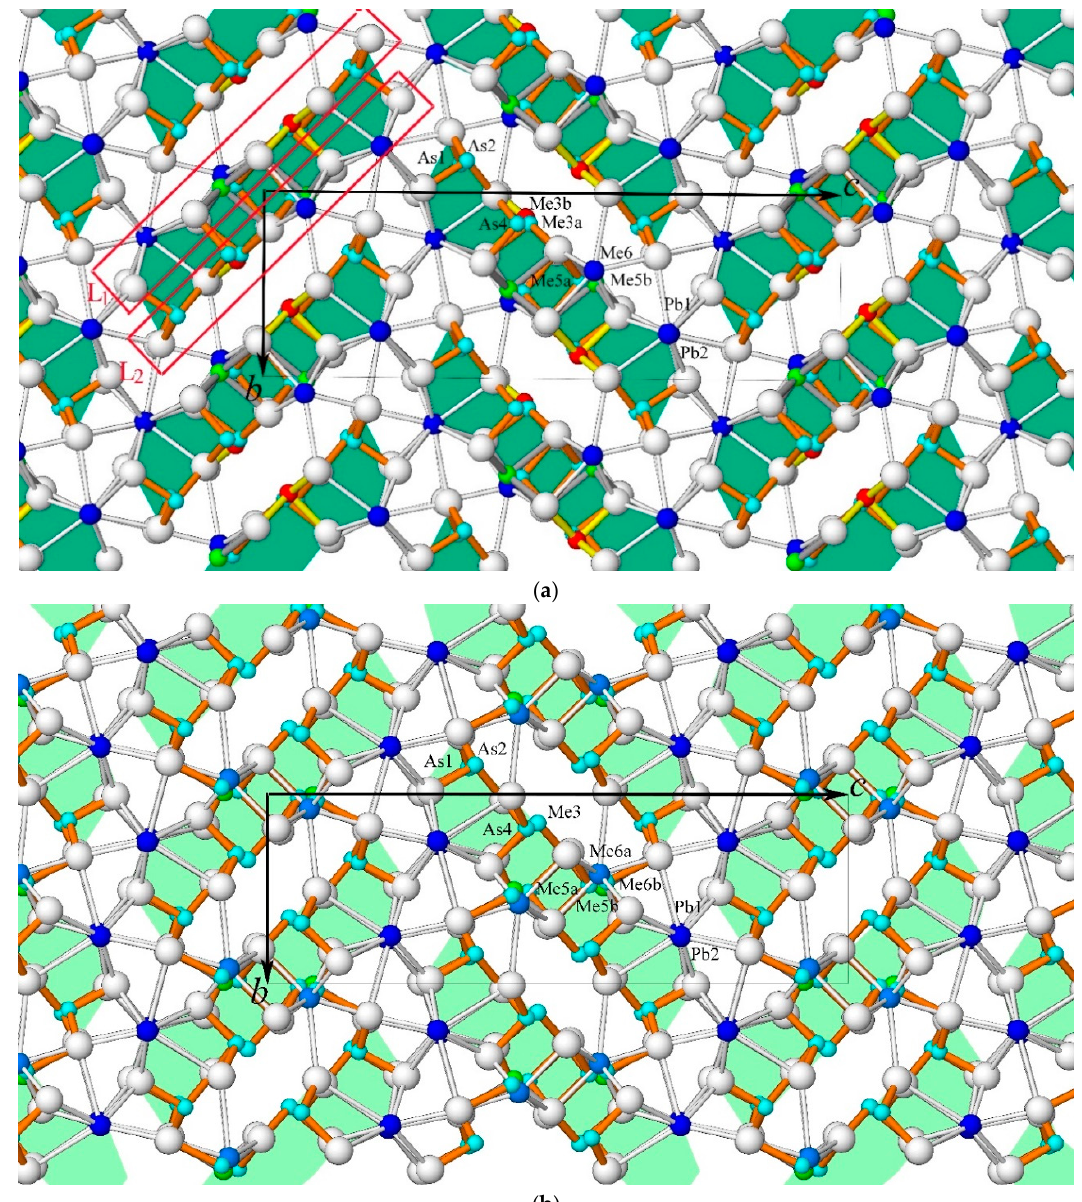
Figure 6. Crystal structures of ( a , top) rath1 (Tl ‐ poorest) and ( b , bottom) rath9 (Tl ‐ richest), in a projection along the a = 8.4 Å axis and including a comparison of their Me3, Me5, and M6 split and mixed sites. White circles represent sulphur sites, blue ones (Pb,Tl) sites, cyan As sites, green the single half ‐ occupied Ag site, red the single partially occupied Sb site, and light blue the single partially occupied Pb site. The dark ‐ green ( a ) and light ‐ green ( b ) ribbons in rath1 and rath9 emphasize their different chemistry, high Pb and high As, respectively. The equivalent SnS ‐ like layers L 1 and L 2 are indicated with red boxes in ( a ).